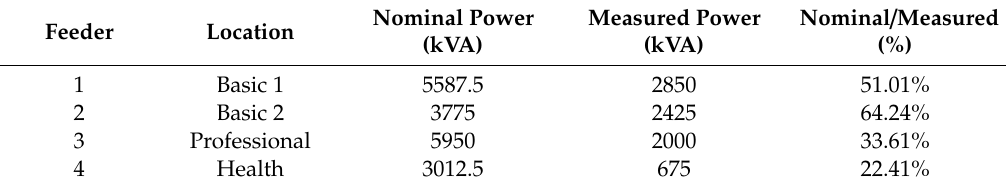
Table 6. Percentage of loads by